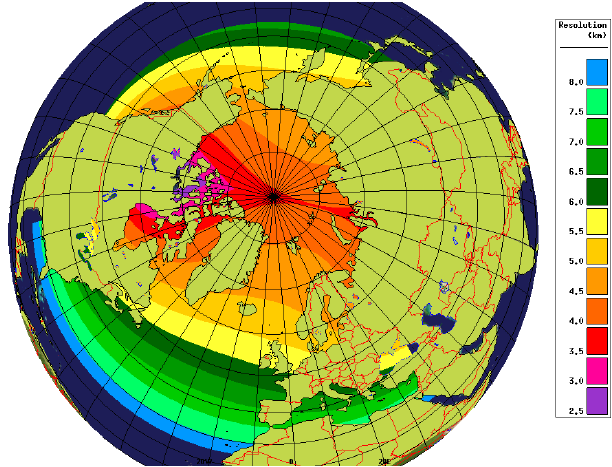
Figure 1. The coverage of the CREG12 extended domain used in RIOPSv2 showing the model grid resolution (km). The domain ex- tends from 26 ◦ N in the Atlantic Ocean over the Arctic Ocean to 44 ◦ N in the Pacific Ocean. The model bathymetry is set to zero for the partially covered regions of the Gulf of Mexico, the Black and Red seas, and for inland